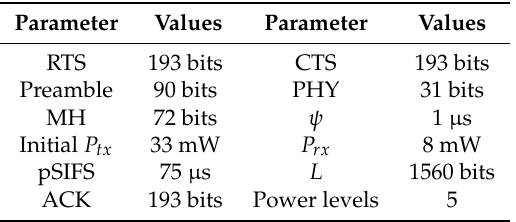
Table 1. Standard parameters for 2400 MHz-2483.5